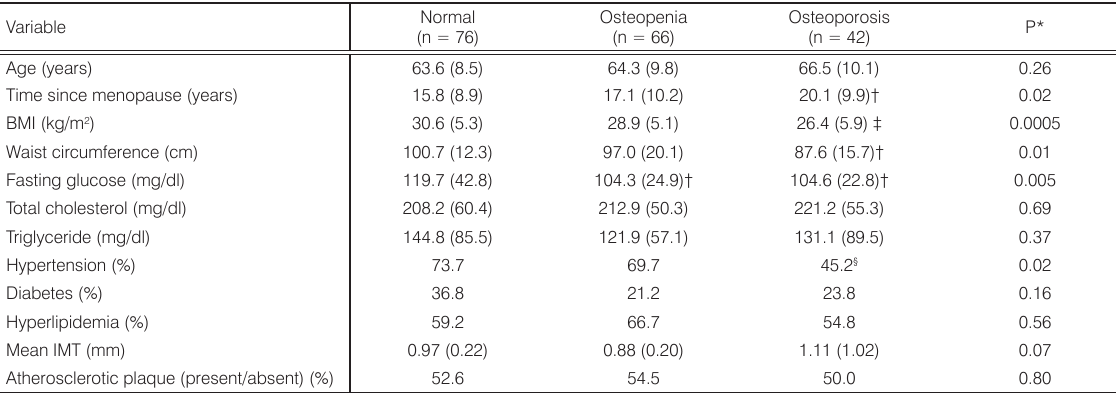
Table 2. Characteristics of postmenopausal women with osteoporosis, osteopenia, and normal BMD at lumbar